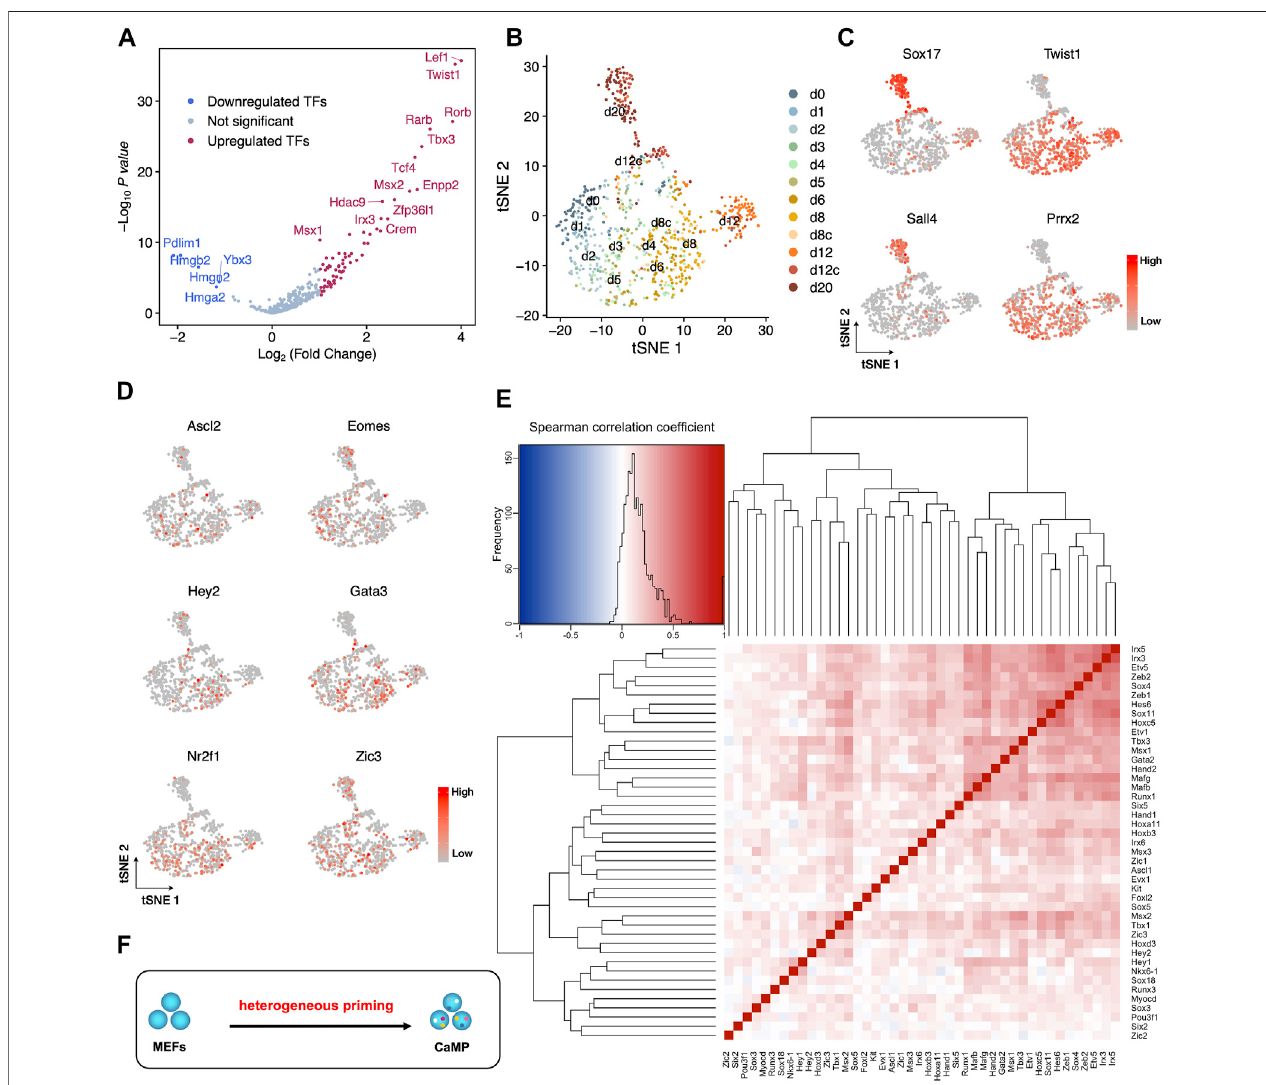
FIGURE 2 | Heterogeneous expression of endogenous development-associated transcription factors in the CaMP phase. (A) Consistent with bulk RNA-Seq, upregulated TFs signi fi cantly increased expression in cells during the fi rst 12 days of C6FAE induction compared with d0 (MEF) measured by single-cell RNA-Seq. The difference of expression for each gene is calculated as the difference of mean log 2 (UMI counts+1). p -value is calculated with two samples unpaired t -test. (B) t-SNE projection of single cells with upregulated TFs list from bulk RNA-Seq during the XEN reprogramming process. d8c and d12c, cells picked from colonies of day 8 (d8c) and day 12 (d12c). (C) Expression of XEN master genes ( Sox17 , Sall4 ) and MEF master genes ( Twist1, Prrx2 ) in the t-SNE projection. (D) Examples of gene expression of activated development-associated TFs in individual cells on the t-SNE projection. (E) Spearman correlation between each pair of the three germ layer master genes. Left top: in the color key, color indicates the value (blue to red: − 1 to 1), and histogram (black curve) indicates the statistic of Spearman correlation coef fi cients in the heatmap. (F) Schematic diagram of stochastic activation of endogenous TFs in the CaMP state.